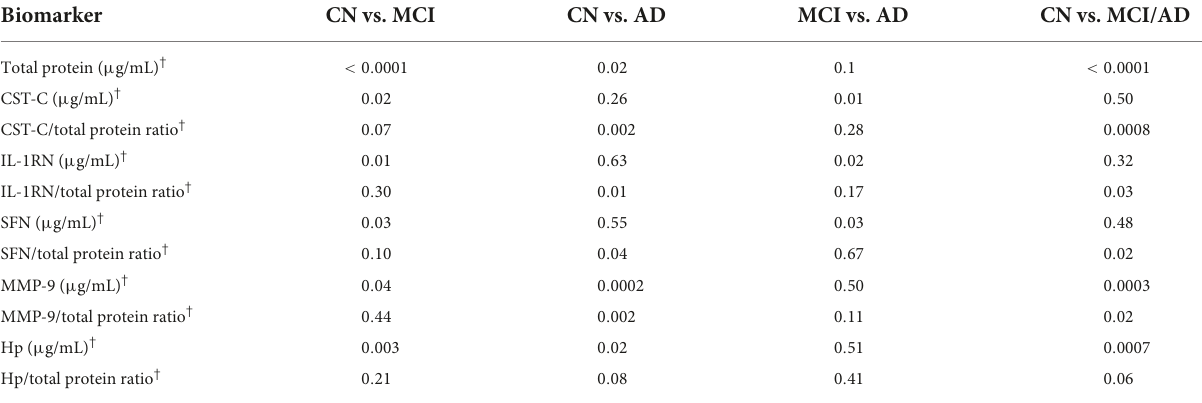
TABLE 2 Univariate model analysis of biomarkers in SAND cohort saliva.